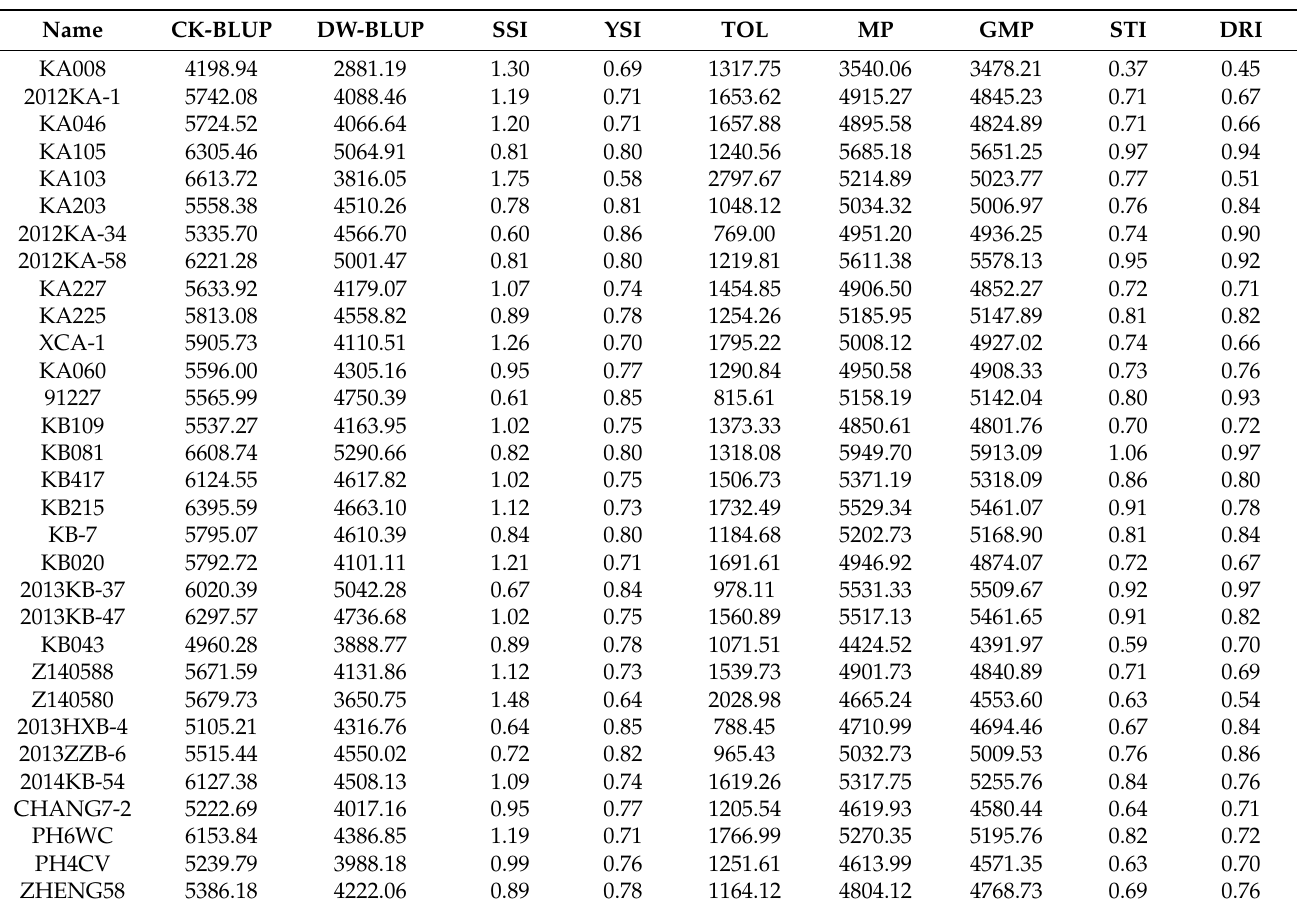
Table 3. Best linear unbiased predictor (BLUP) values of yield and seven drought tolerance indices of 31 inbred lines of